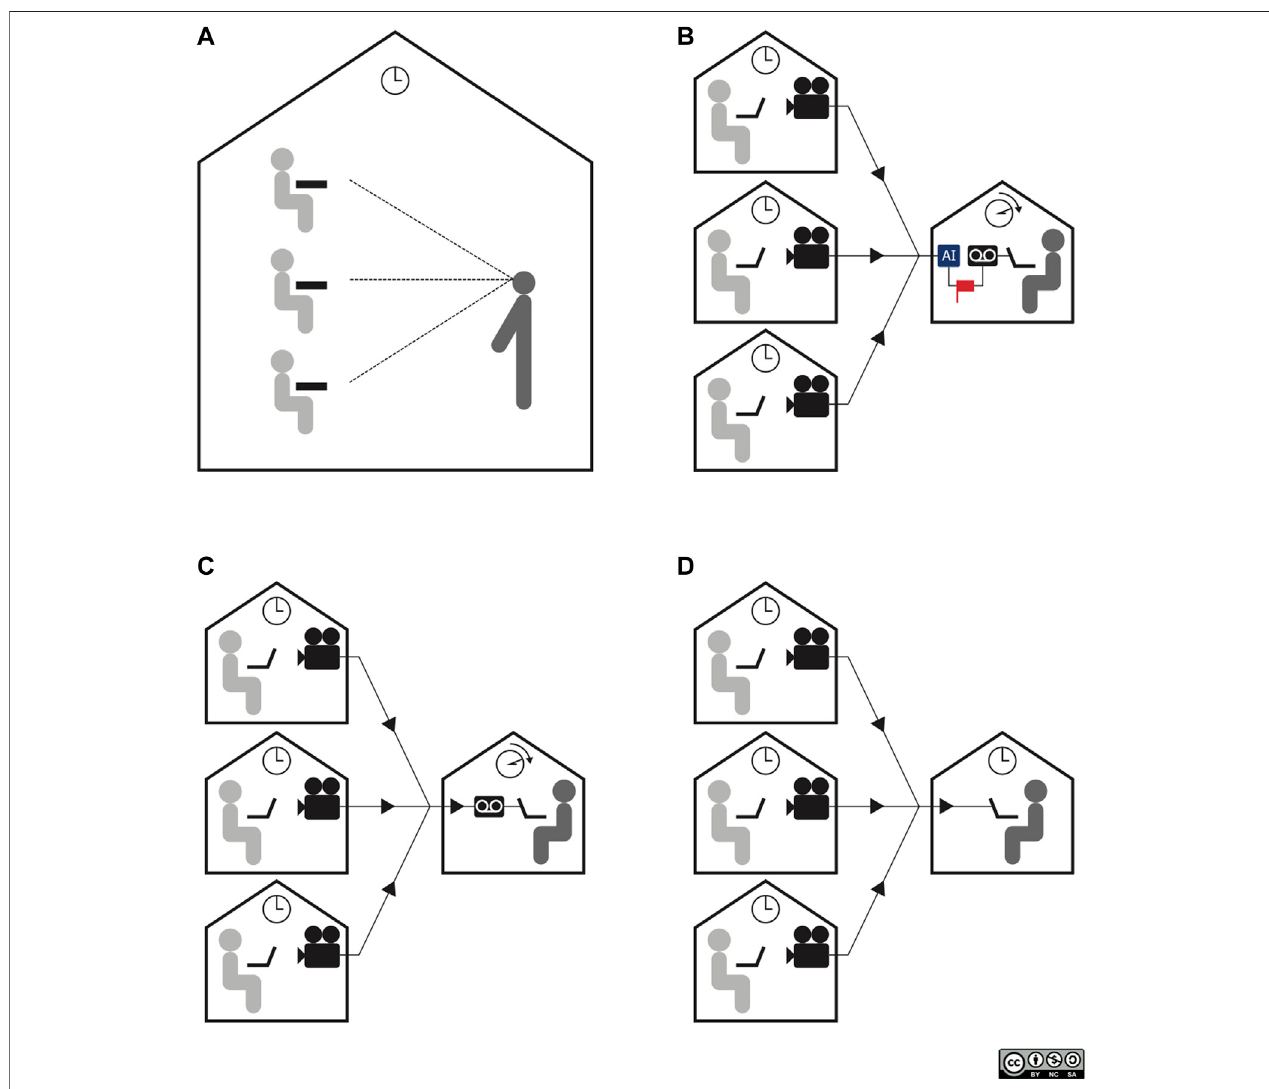
FIGURE 1 | Four types of proctoring: (A) in-person, (B) video summarization, (C) web video recording, and (D) live online